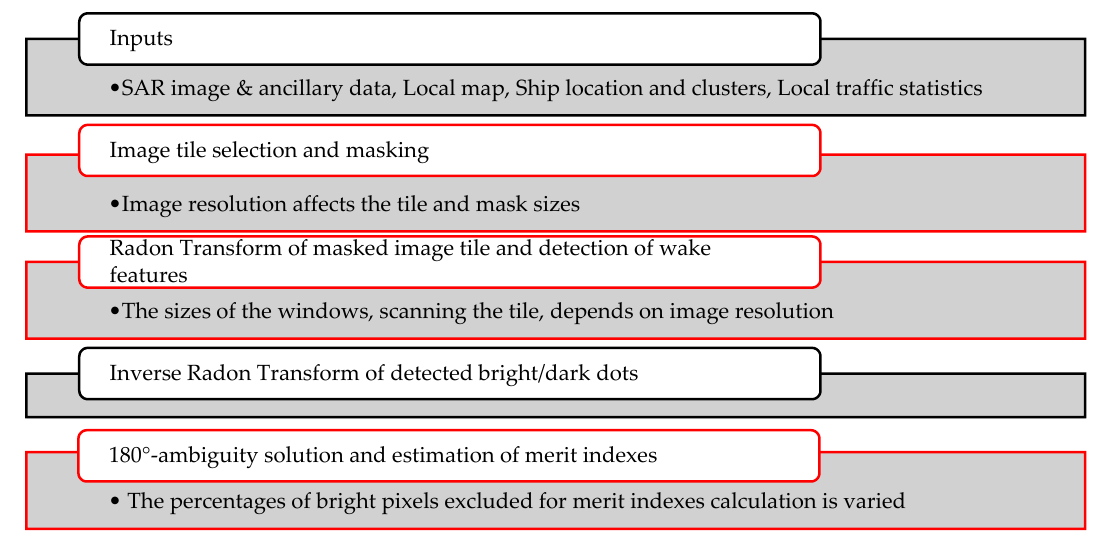
Figure 4. Flow-chart of the wake detection algorithm. The modified steps are shown in red.